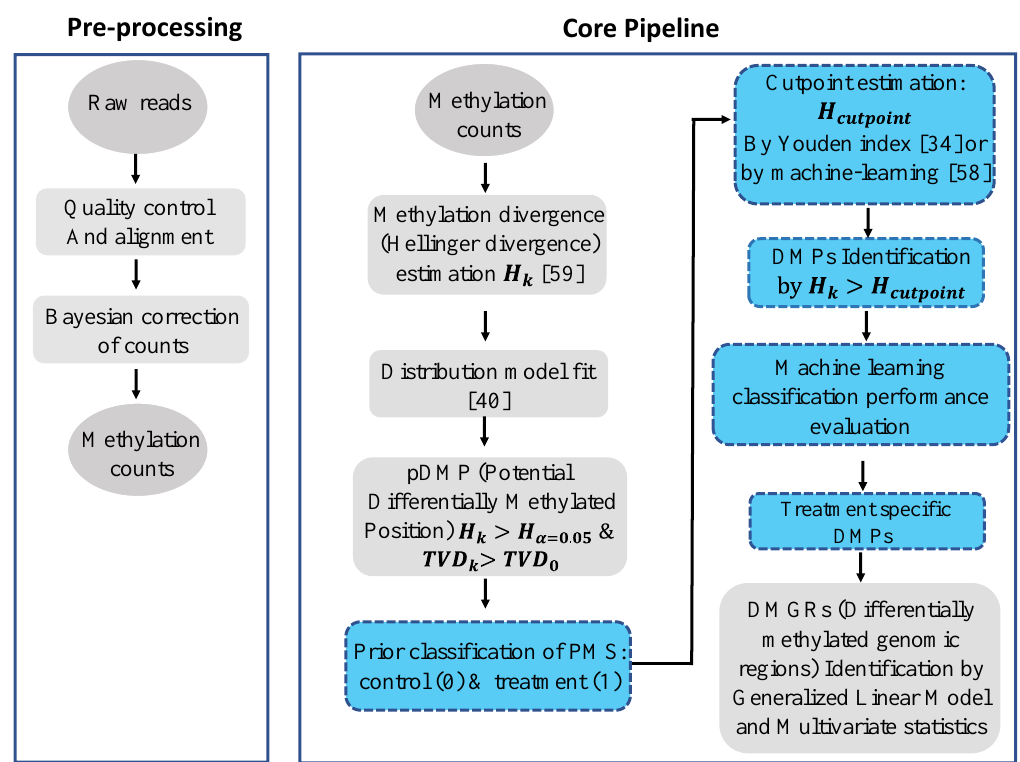
Figure 2. Flow diagram of the signal detection and machine learning approach applied in our methylation analysis study. The approach is implemented in the R package Methyl-IT, which is available at GitHub: https://github.com/genomaths/MethylIT. Ovals represent input and output data, squares represent processing steps, with signal detection processing and machine learning steps highlighted in blue. For the machine learning classification performance evaluation, data from independent individuals in the same population are preferred. The final step shown (DMGRs) is not included in the current study, but is an analytical step that can be accomplished with Methyl-IT. Related references are cited accordingly for each key step. Table 1. Summary of the datasets generated for simulation experiments.